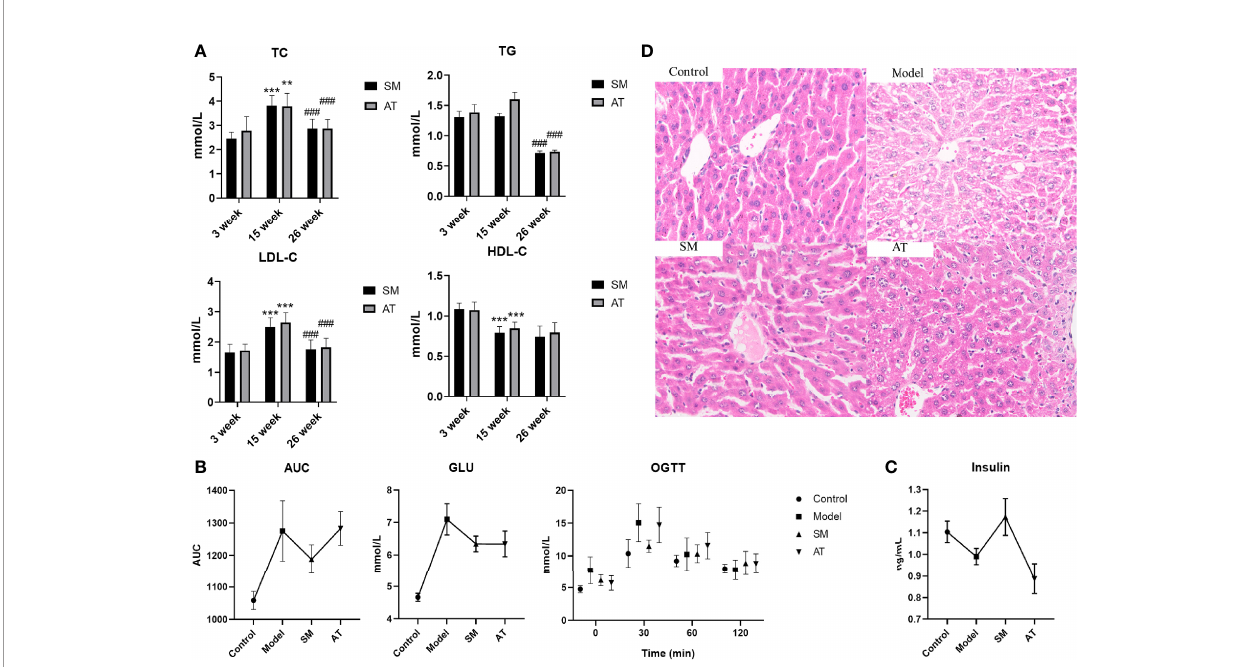
FIGURE 1 | (A) Comparisons in TG, TC, LDL-C, and HDL-C between SM and AT groups. 3 weeks, 15 weeks, and 26 weeks represent before modeling, 12 weeks after modeling, and 11 weeks after drug administration, respectively. “ * ” represents a signi fi cant difference compared to 3 weeks and 15 weeks; “ # ” represents a signi fi cant difference compared to 15 weeks and 26 weeks. (B) Blood glucose levels and areas under the curve (AUC) during the oral glucose tolerance test (OGTT). (C) Change in insulin level. (D) Histopathologic sections of liver, H&E